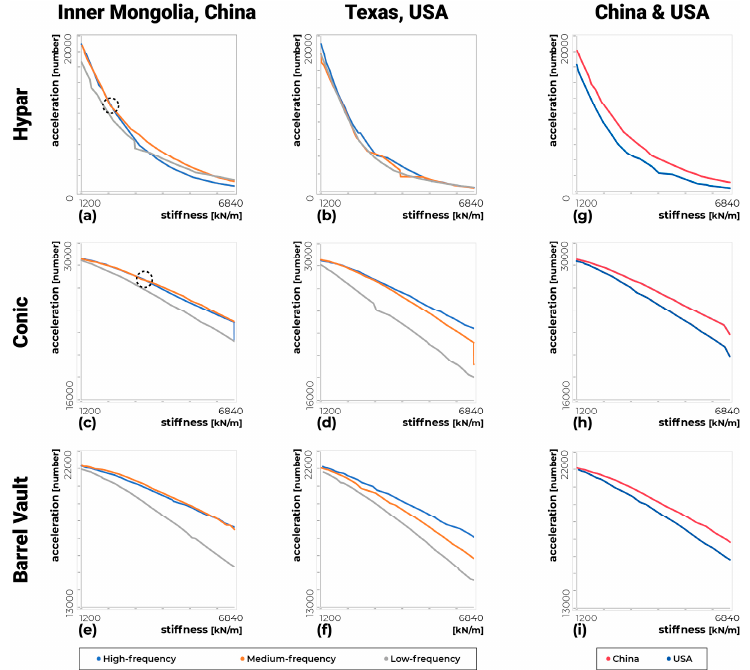
Figure 6. Three different types of alternatives for the last generation. Figure 6. Three di ff erent types of alternatives for the last Table 2. Reduction rate of the acceleration value.